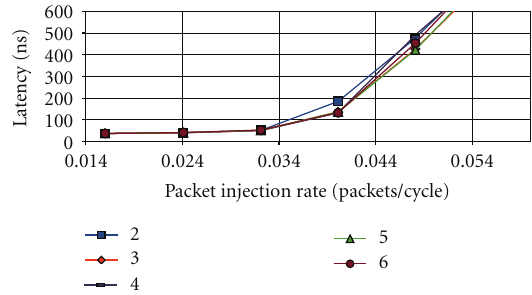
Figure 11: Latency as number of virtual channels is varied for ami25 .